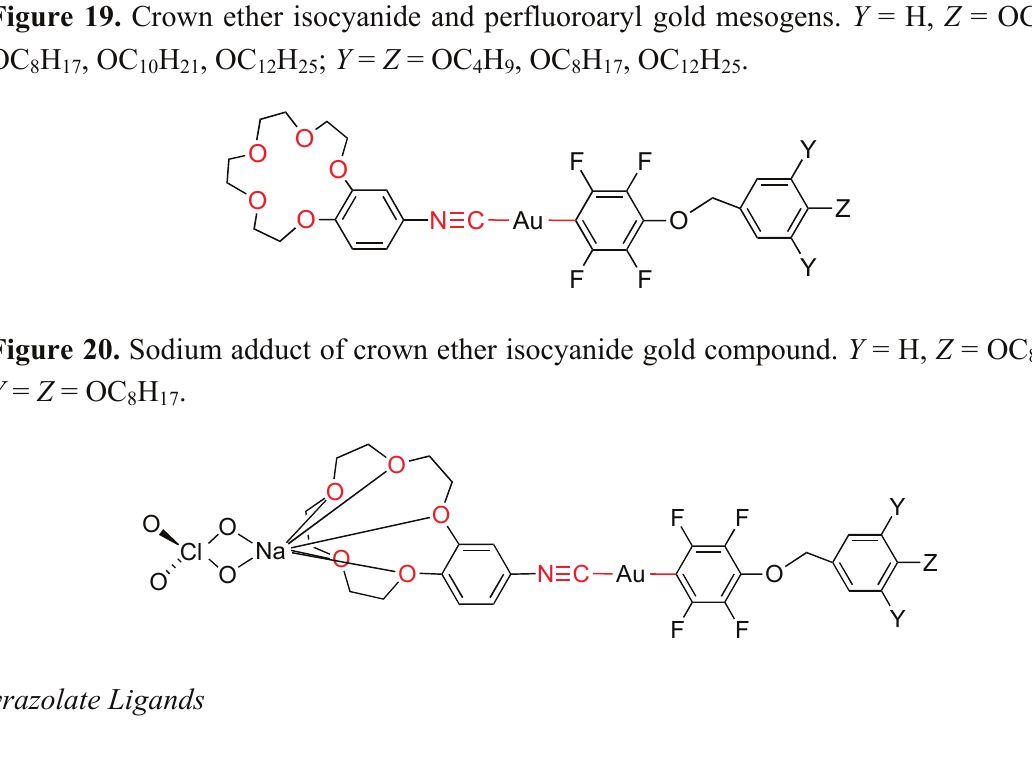
Figure 19. Crown ether isocyanide and perfluoroaryl gold mesogens. Y = H, Z = OC